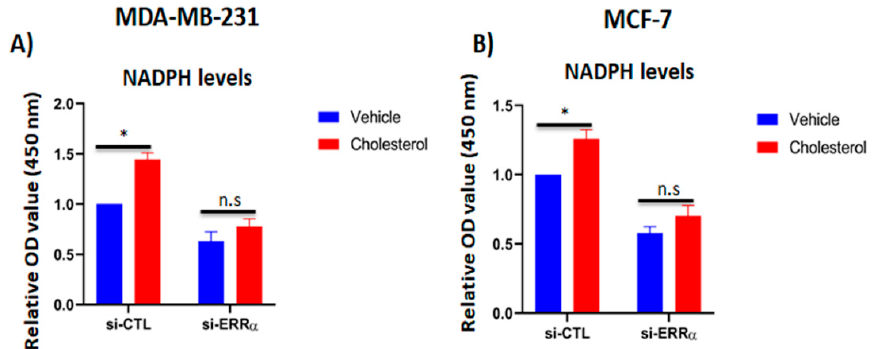
Figure 6. Cholesterol increases NADPH levels in breast cancer cells via ERR α pathway. ( A , B ) The intracellular NADPH levels were quantified using the NADP + /NADPH assay kit. MDA-MB-231 and MCF-7 cells were transfected with either siRNA-control (si-CTL) or siRNA-ERR α (si-ERR α ) for 48 h, followed by treatment with vehicle or cholesterol (5 µ M for MDA-MB-231 cells, and 10 µ M for MCF-7 cells) for 24 h. A value of p < 0.05 was considered significant (*). N.S./n.s. = not